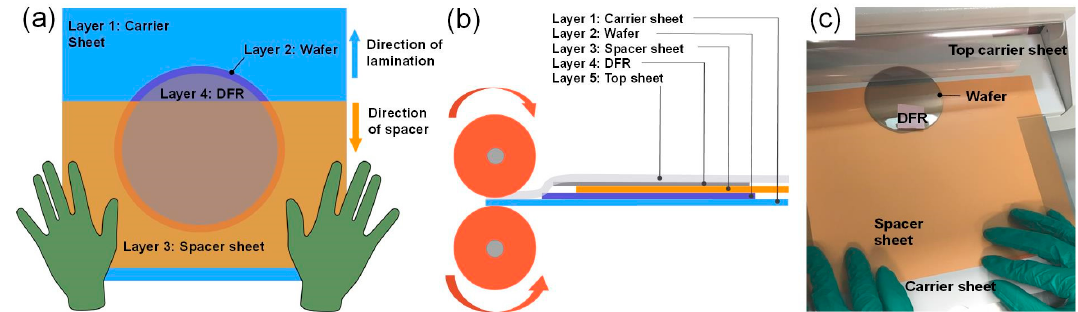
Figure 1. Dry film photoresist lamination procedure. ( a ) Top view schematic of the film-wafer lamination assembly. The top carrier sheet of the lamination pouch is not shown; ( b ) side view schematic of the film-wafer lamination assembly. The top carrier sheet (layer 5) of the lamination pouch is shown here; ( c ) photograph of the assembly prior to lamination: Carrier sheet (white), spacer sheet (orange) and DFR (pink) are illustrated. The spacer sheet (layer 3) is held as the rollers pull the assembly into the laminator. The spacer sheet ensures gradual lamination and avoids formation of air bubbles. The top and bottom carrier layers (layers 1 and 5) protect the DFR from sticking to the rollers and any dust particles. Table 1. Process parameters for ADEX films.